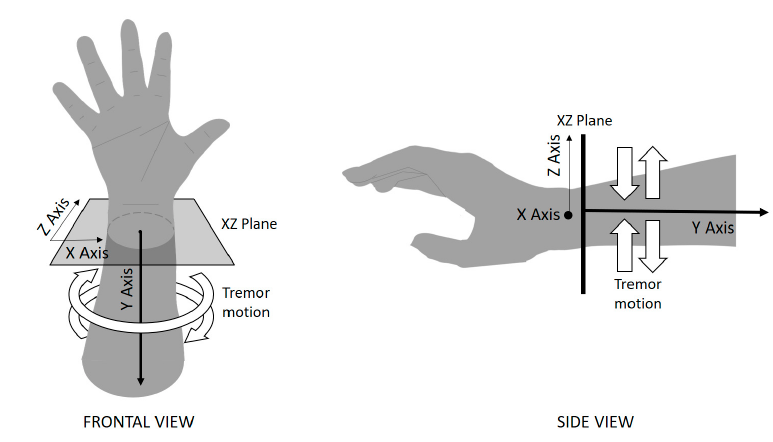
Figure 7. In patients with Parkinson’s disease, a tremor is present in the XZ plane, and the Y -axis acts as the axis of rotation for this movement. as the axis of rotation for this